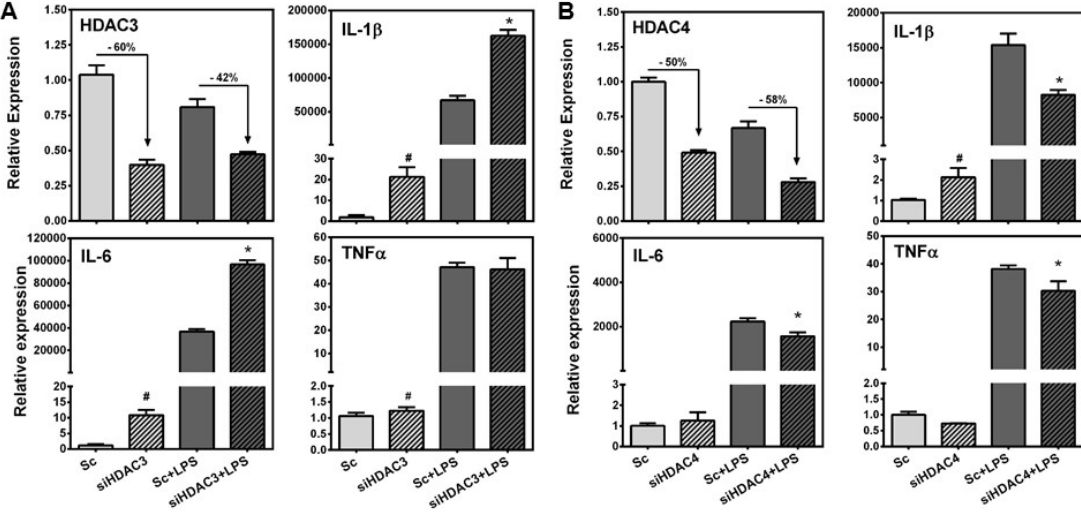
Figure 5. Effects of HDAC3 and 4 knockdown on LPS-induced inflammatory gene expression. RAW 264.7 macrophages were transfected with scrambled control, siRNA against HDAC3 or HDAC4 for 24 h and then cells were stimulated with or without 100 ng/mL of LPS for 3 h for subsequent gene expression qRT-PCR. ( A ) Percent knockdown of HDAC3 (top left), expression of IL-1 β (top right), expression of IL-6 (bottom left), and expression of TNF α (bottom right); ( B ) Percent knockdown of HDAC4 (top left), expression of IL-1 β (top right), expression of IL-6 (bottom left), and expression of TNF α (bottom right). # indicates significantly different from scrambled control ( p < 0.05); * indicates significantly different from scrambled control + LPS ( p < 0.05).